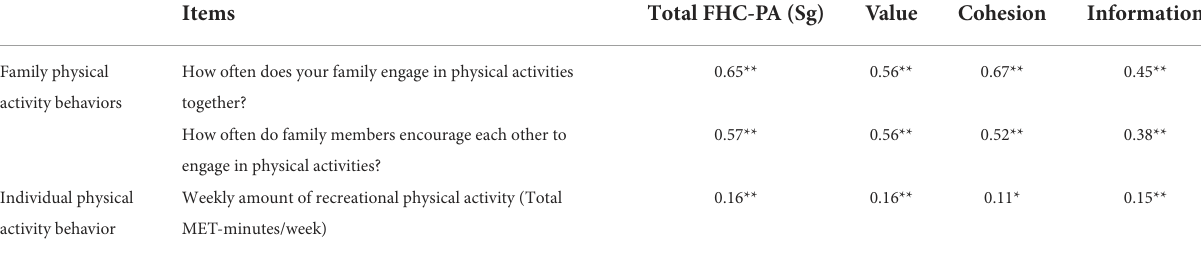
TABLE 8 Pearson’s correlations for FHC-PA (Sg) with family- and individual-level physical activity behaviors.